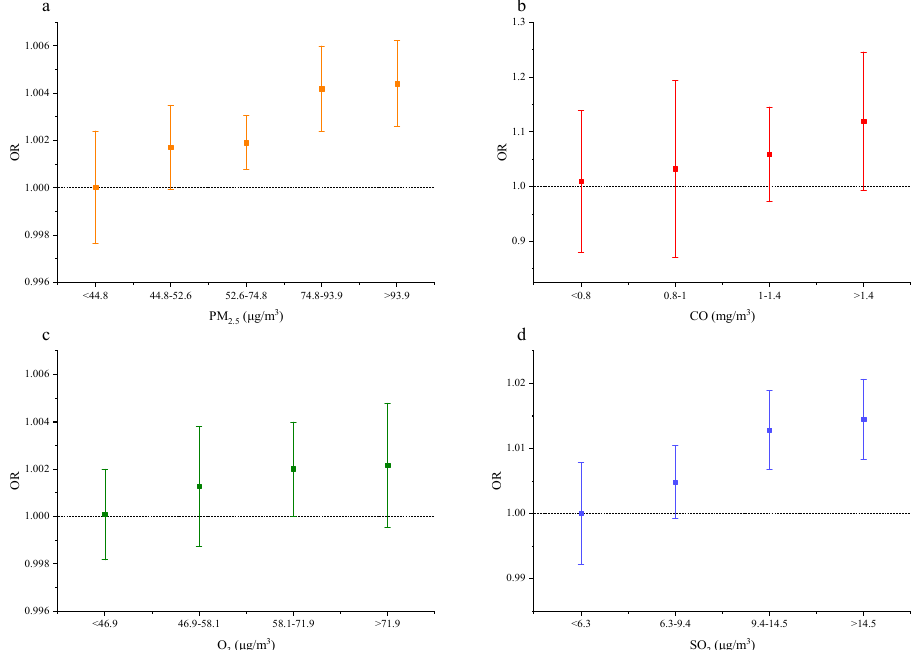
Figure 4. Influence of the four air pollutants on the risk of gynecological cancer in different ranges in Phase 4. ( a – d ), The OR of gynecological cancer with respect to PM 2.5 ( a ), CO ( b ), O 3 ( c ), and SO 2 ( d ) exposure. The ORs of gynecological cancer with respect to PM 2.5 , CO, SO 2 , and O 3 exposure. Here we controlled confounders. For a 1.0- µ g/m 3 increase in SO 2 exposures, the OR of gynecological cancer was 1.000 (95% CI, 0.992–1.008) for SO 2 < 6.3 µ g/m 3 , 1.005 (95% CI, 0.999–1.010) for SO 2